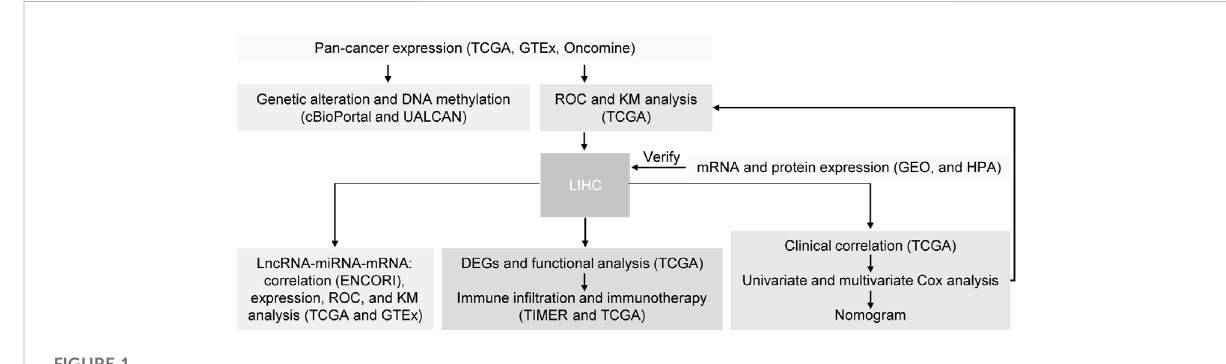
FIGURE 1 Schematic pipeline of data collection and